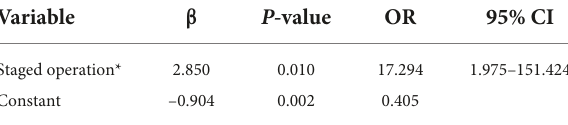
TABLE 2 Logistic regression analysis of risk factors of GO-associated